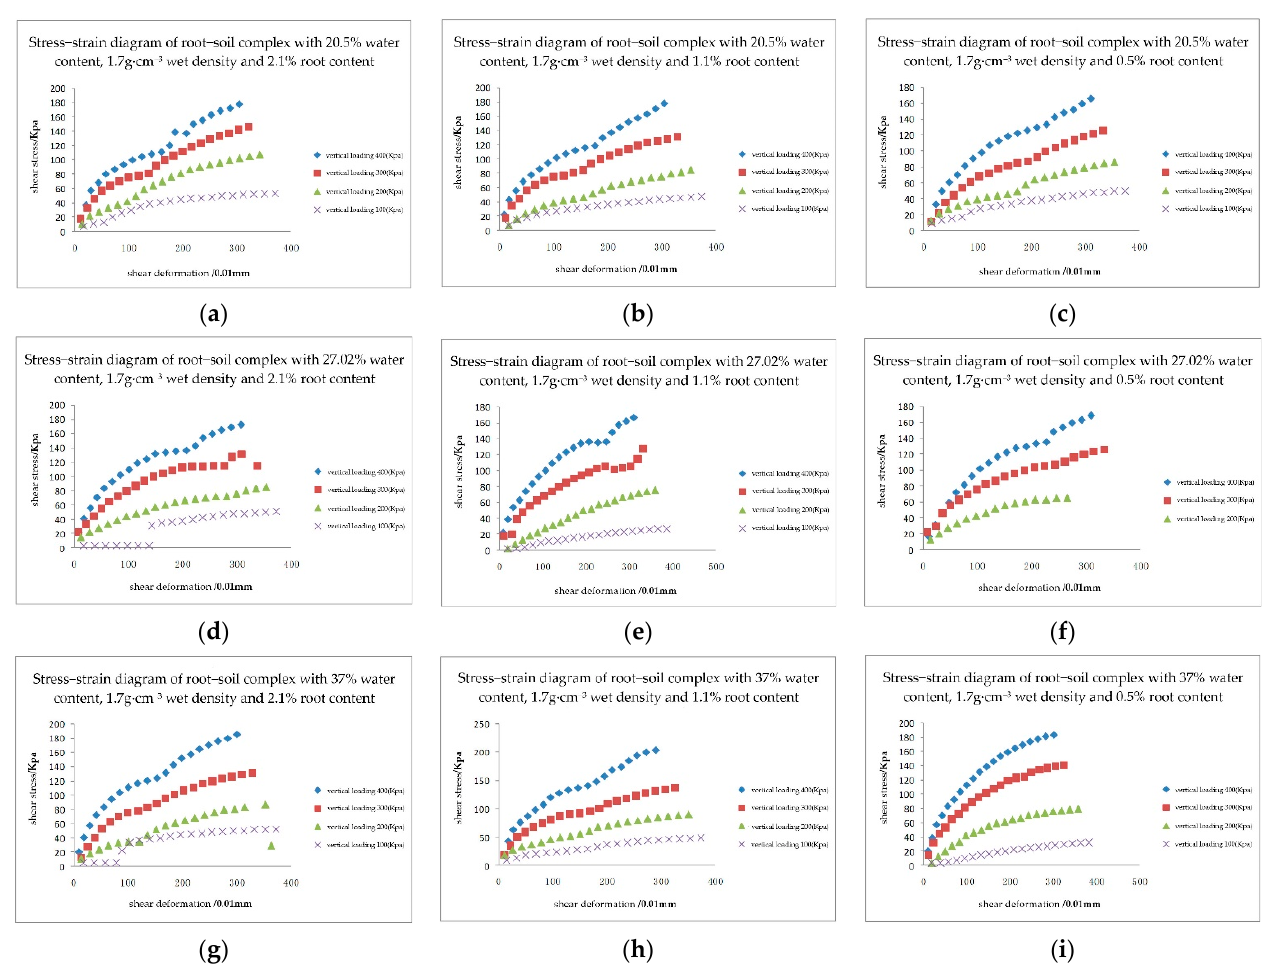
Figure 4. Relationship between shear stress and shear deformation of samples with 20%, 30%, and 40% water content. Note: ( a ) 20.5% water content, 1.7g·cm − 3 wet density, 2.1% root content. ( b ) 20.5% water content, 1.7 g·cm − 3 wet density, 1.1% root content. ( c ) 20.5% water content, 1.7 g·cm − 3 wet density, 0.5% root content. ( d ) 27.02% water content, 1.7 g·cm − 3 wet density, 2.1% root content. ( e ) 27.02% water content, 1.7 g·cm − 3 wet density, 1.1% root content. ( f ) 27.02% water content, 1.7 g·cm − 3 wet density, 0.5% root content. ( g ) 37% water content, 1.7 g·cm − 3 wet density, 2.1% root content. ( h ) 37% water content, 1.7 g·cm − 3 wet density, 1.1% root content. ( i ) 37% water content, 1.7 g·cm − 3 wet density, 0.5% root content.